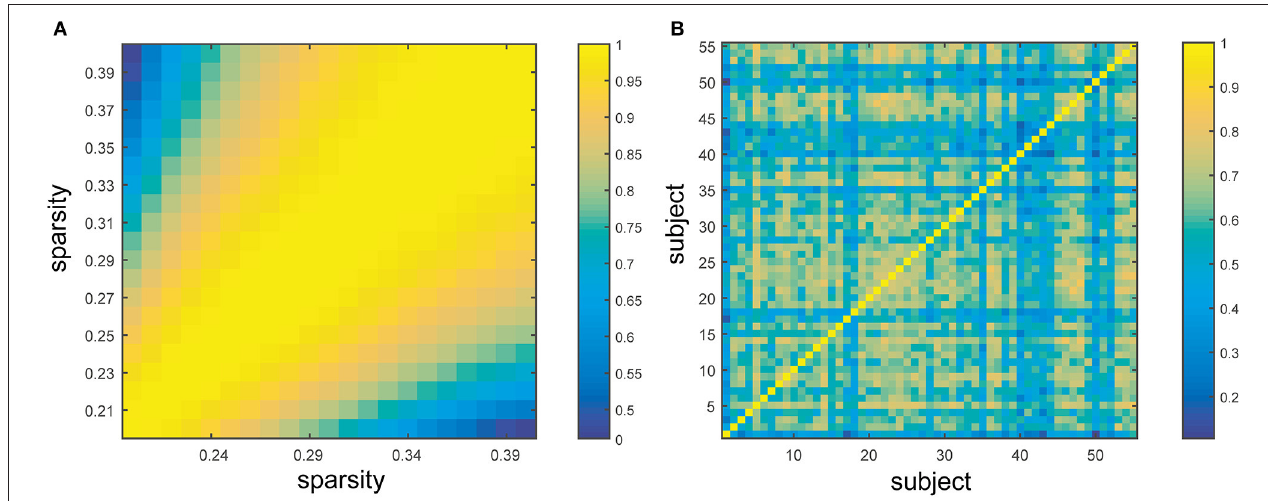
FIGURE 5 | Similarity across sparsities and subjects. (A) Represents the similarity between different sparsities from 20 to 40% with the step size of 1%. (B) Exhibits the similarity between different subjects. The color bar shows the extent of similarity with blue as dissimilar and yellow as similar.